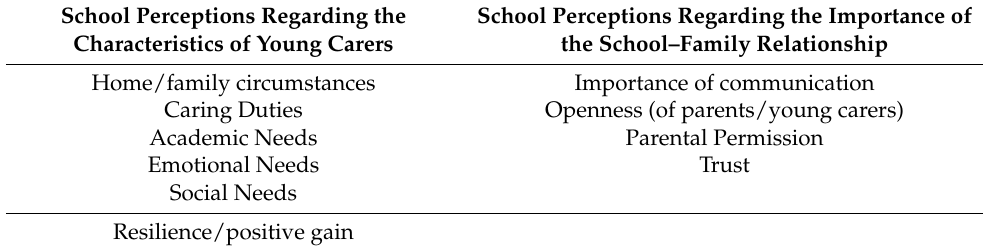
Table 2. Table of Themes. School Perceptions Regarding